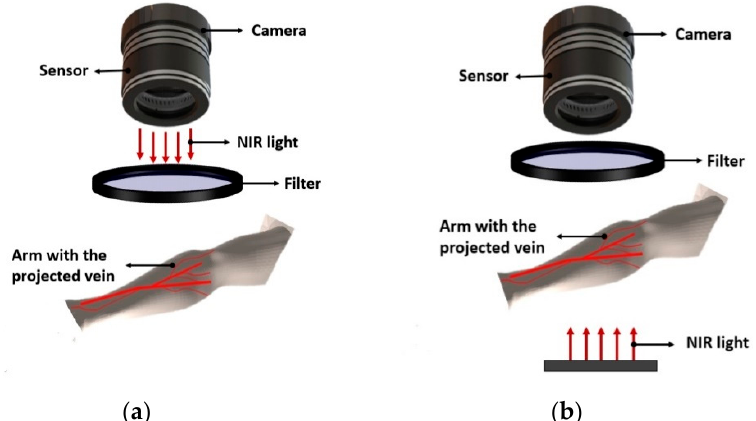
Figure 2. Basic components of a near infrared (NIR) vein finder prototype: ( a ) Reflected light type, and ( b ) transillumination type.